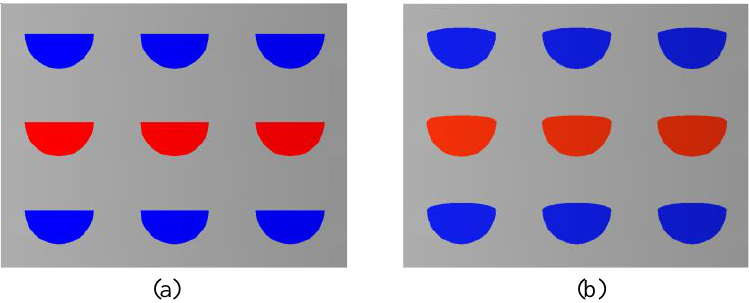
Figure 1. Cross-section of the printed circuit heat exchanger (PCHE) circuit ( a ) common cross flow section ( b ) improved with the additional elliptical upper channel.